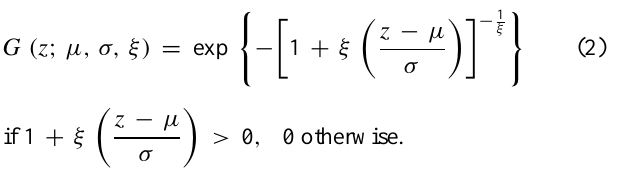
Lower panel: corresponding return level plots.